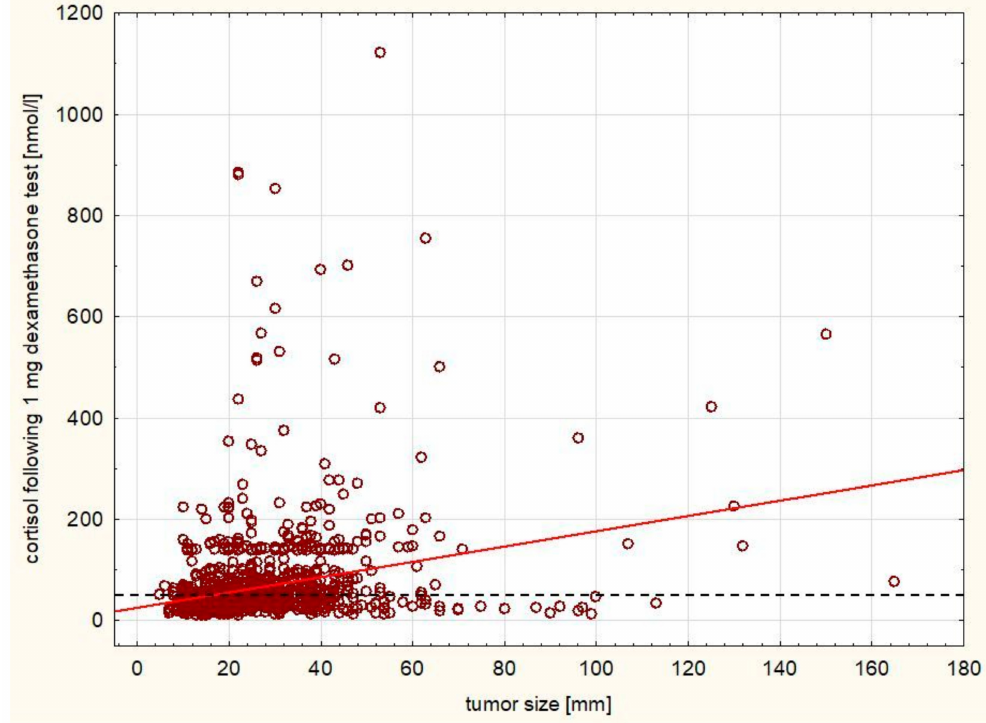
Figure 3. Positive correlation between the size of the tumor and morning cortisol level following 1 mg dexamethasone test (r = 0.2628, p < 0.005). The cut-o ff value for normal range is marked with a dashed